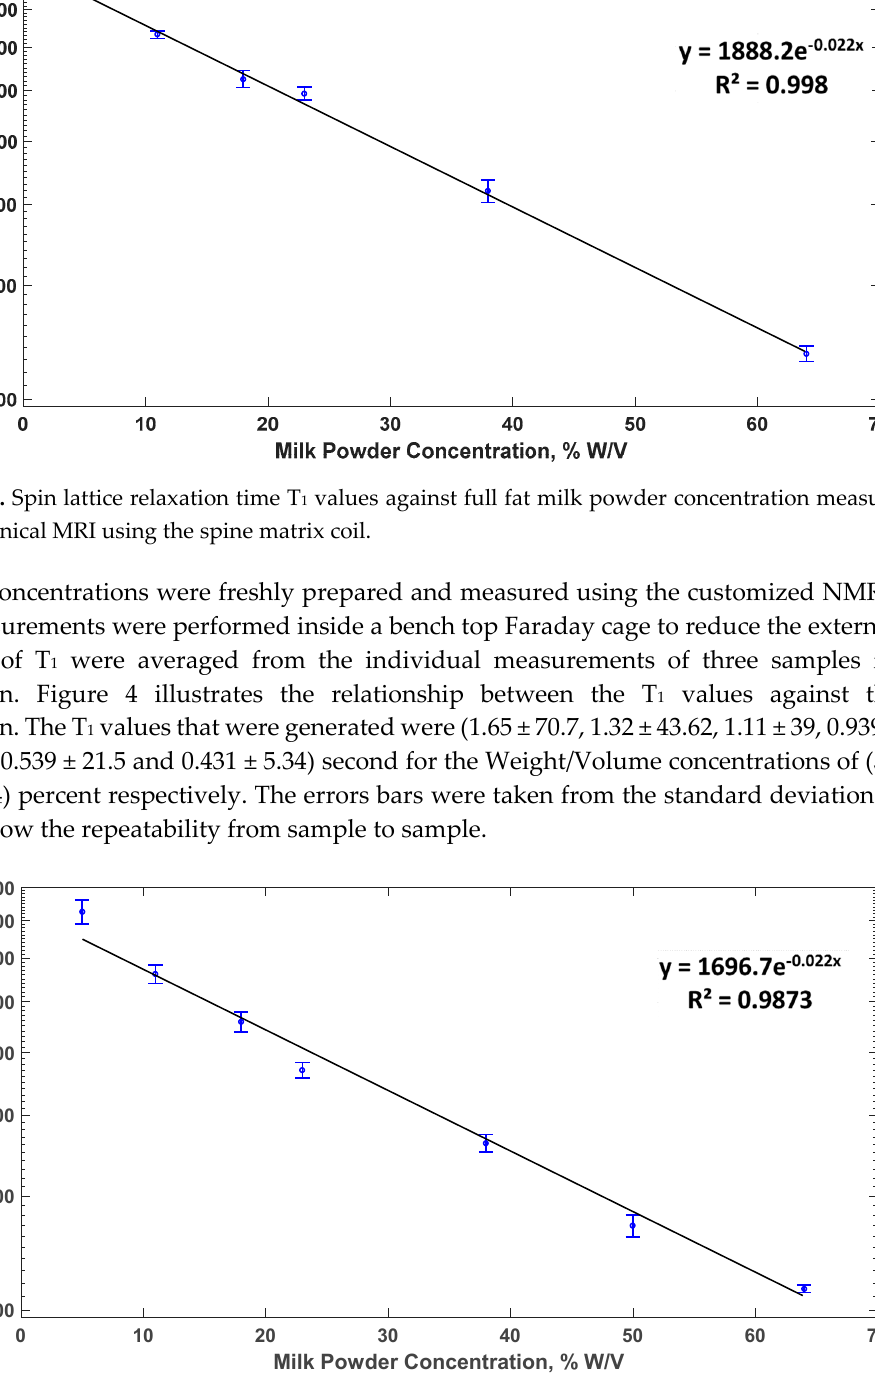
Figure 4. Spin lattice relaxation time T 1 values against full fat milk powder concentration measured using a customized MR sensor. The error bars show the standard deviation of the